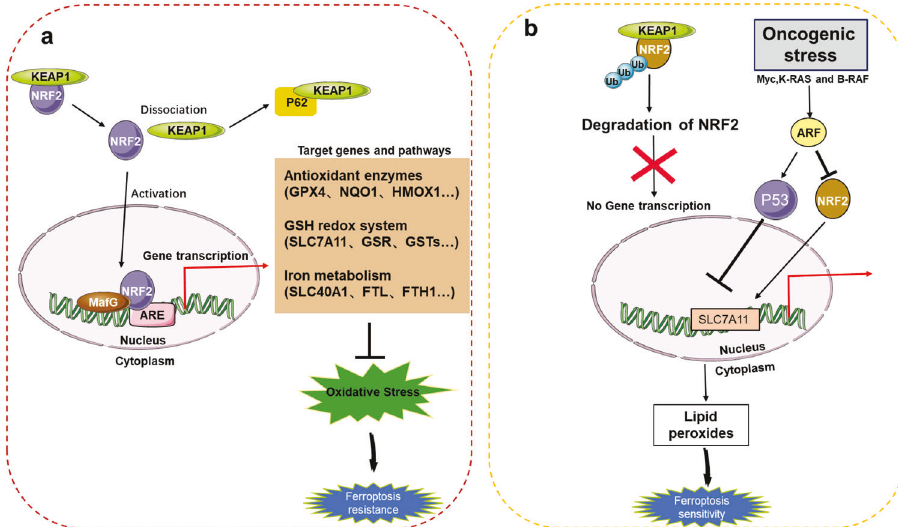
Fig. 3 NRF2 and the ferroptosis network. a p62-mediated degradation of KEAP1 contributes to the activation of NRF2 in ferroptosis. The activated NRF2 enters the nucleus to initiate the transcription of antioxidant enzymes, glutathione redox system, iron metabolism, and other related molecules, alleviating oxidative stress, making tumor cells resistant to ferroptosis. b When NRF2 is degraded by ubiquitination, it cannot enter the nucleus to initiate the transcription of related genes. Second, ARE is a key regulator of NRF2-mediated SLC7A11 activation, and the ARE-NRF2 interaction is a p53-independent enhanced ferroptosis sensitivity approach.